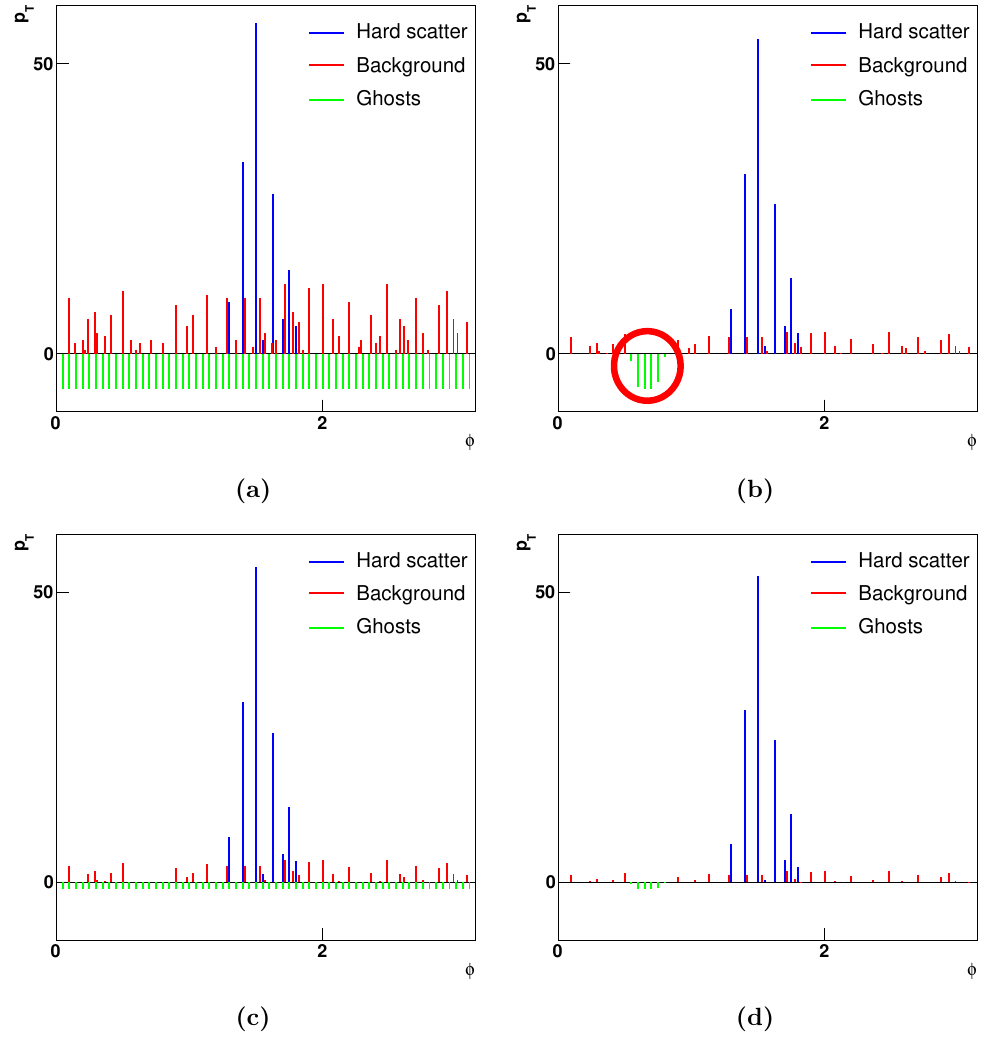
Figure 1. Illustration of the ICS method with 2 iterations assuming only one dimension in az- imuth. The event before the (cid:12)rst iteration (1a) contains hard-scatter particles, background particles and ghosts with p T corresponding to (cid:26) in that event. To emphasize the fact that the ghosts are subtracted, their p T is negative in these (cid:12)gures. After the (cid:12)rst iteration with (cid:12)nite (cid:1) R max (1b), ghosts with unsubtracted p T can remain in the event (emphasized by a red circle). The scalar p T sum of the unsubtracted ghosts is redistributed uniformly in the y (cid:0) (cid:30) plane (1c) or according to the actual (cid:26) dependence. After the second iteration (1d), the unsubtracted background p T is strongly